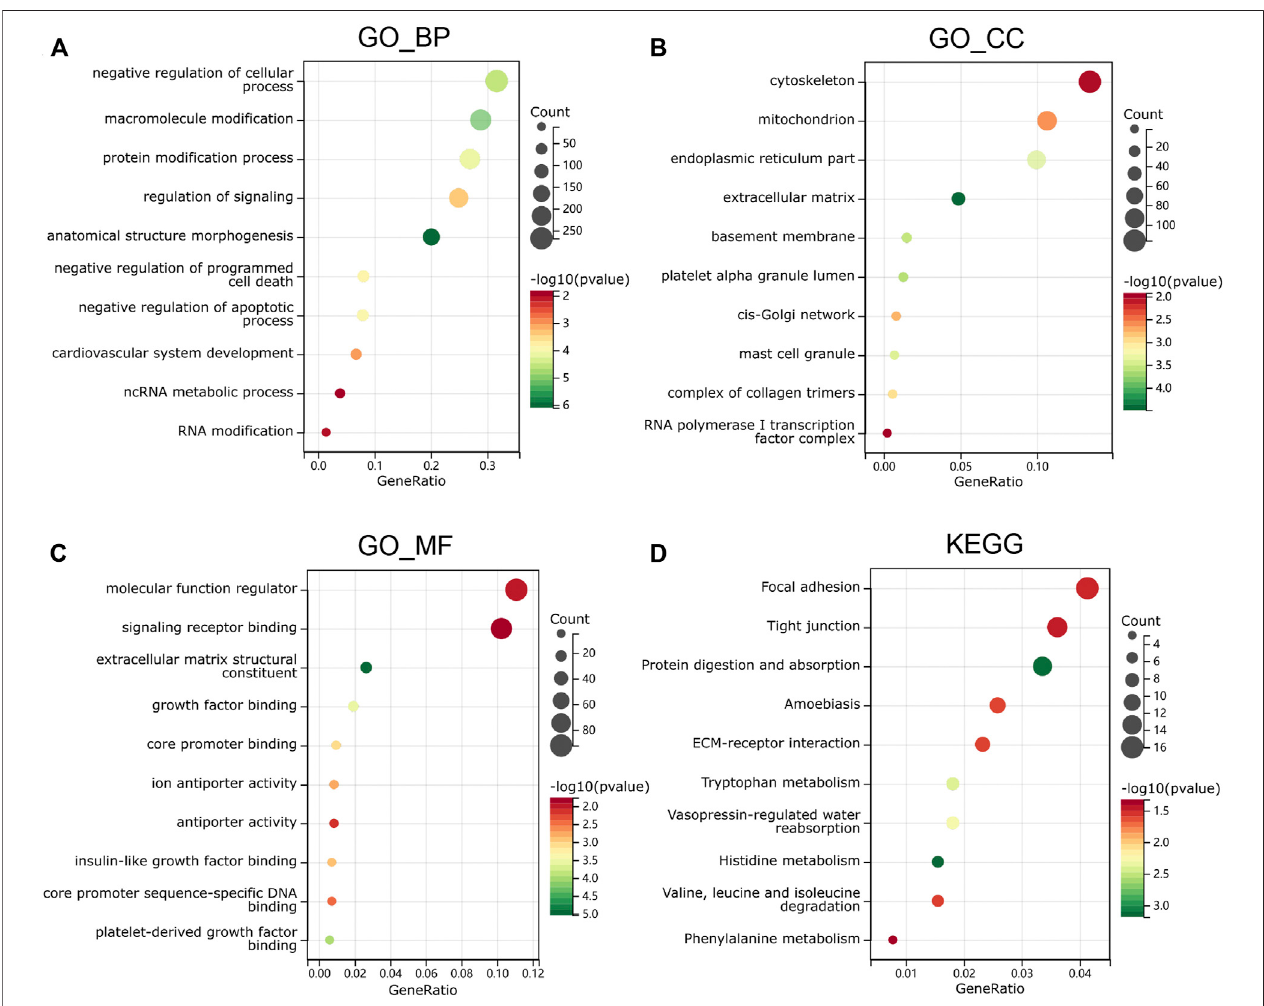
FIGURE4| FunctionalenrichmentanalysisinGOandKEGG. (A) biologicalprocess, (B) molecularfunctionand (C) cellcompositionofGOenrichmentanalysis. (D) Kyoto Encyclopedia of Genes and Genomes analysis results of differentially expressed gender-related genes between male and female. The words on the left indicates enriched terms, the size of the balls indicates the number of the genes enriched and the color indicates the level of the enrichment.